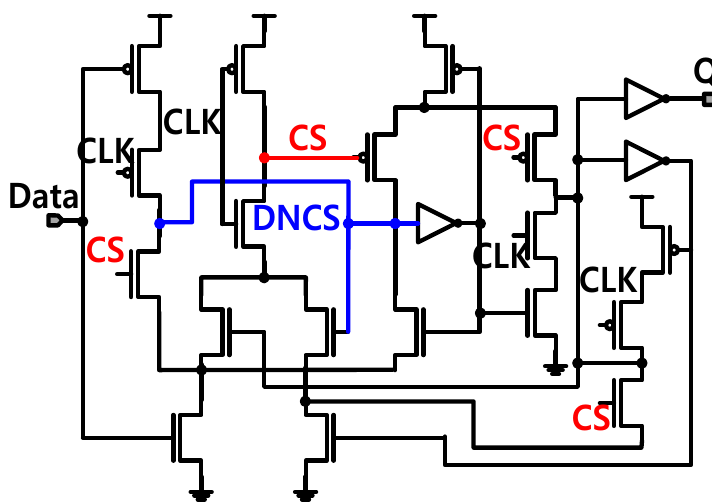
Figure 3. Static Single-phase Contention-free Flip-Flop (S 2 CFF).